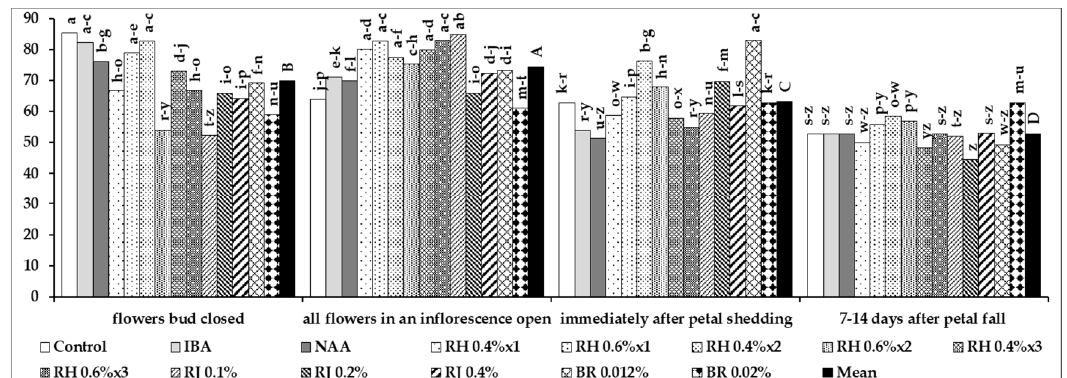
Figure 11. The influence of rooting enhancers on soluble proteins content ( μ g mg − 1 FW) in leaves of Rosa ‘Maiden’s Blush’ cuttings harvested from shoots in four phenological stages of shoots. Control—the control cuttings; IBA 0.4%—Ukorzeniacz A aqua (0.4% IBA); NAA 0.2%—Ukorzeniacz B aqua (0.2% NAA); RH 0.4%×1, RH 0.6%×1—watering with 0.4% or 0.6% Bio Rhizotonic (10 mL) after planting; RH 0.4%×2, RH 0.6%×2—watering with 0.4% or 0.6% Bio Rhizotonic (10 mL) after planting and 10 days later; RH 0.4%×3, RH 0.6%×3—watering with 0.6% Bio Rhizotonic (10 mL) after planting, 10 and 20 days later; RJ 0.1%, RJ 0.2%, RJ 0.4%—watering with 0.1%, 0.2%, or 0.4% Root Juice™ (10 mL) after planting; BR 0.012%, BR 0.02%—watering with 0.012% or 0.02% Bio Roots (10 mL) after planting.